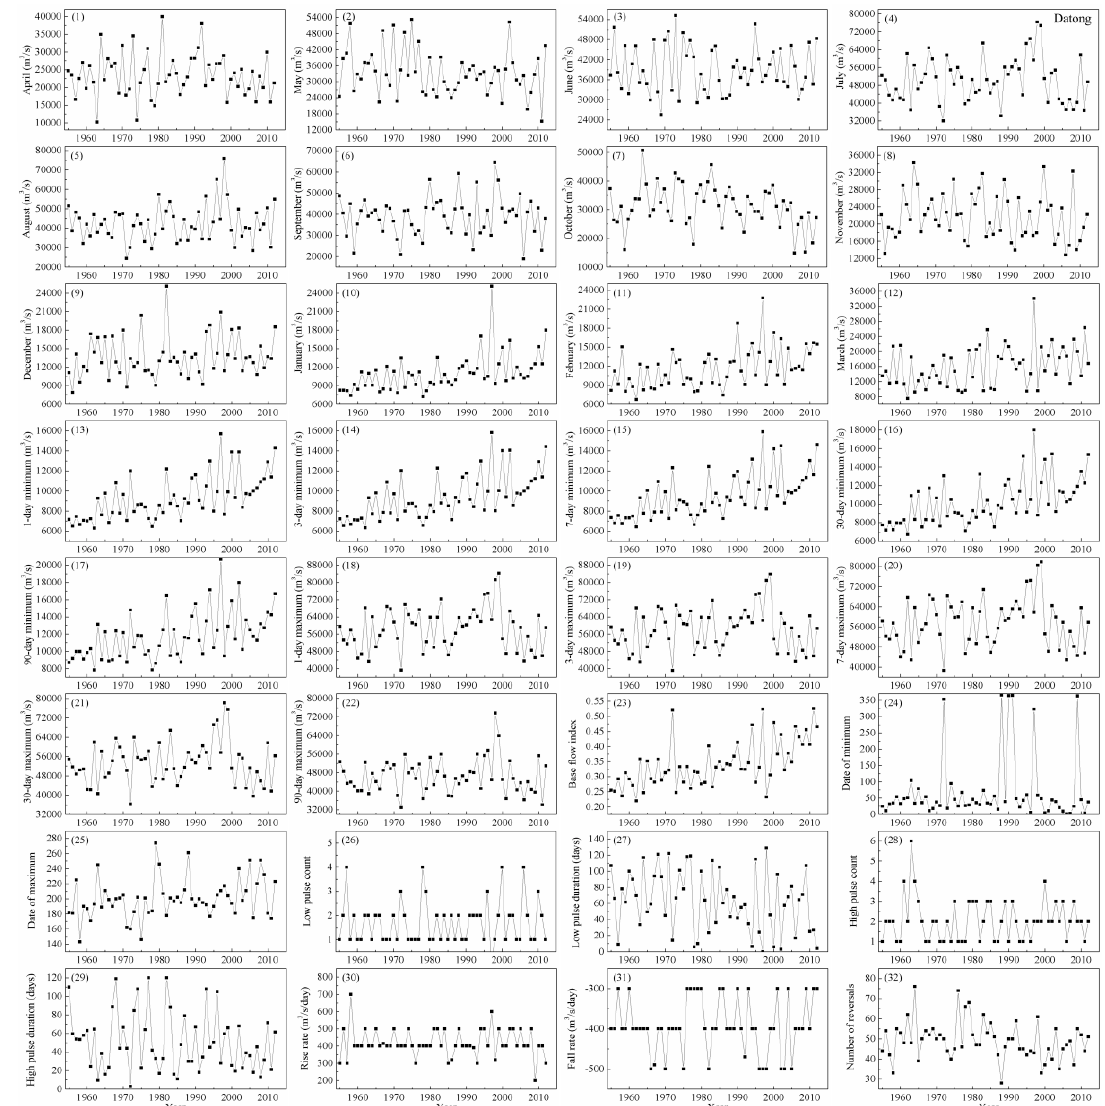
Figure 12. IHA series of the Datong station.